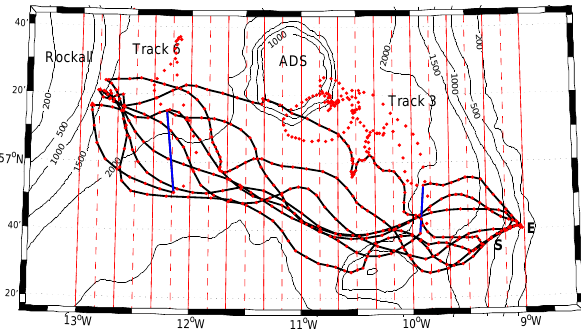
Figure 5. Glider track in the Rockall Trough from 18 October 2009 (S) to 5 March 2010 (E). Red dots are the dive positions. The black track connects those points used for averaging, with the blue lines connecting the gaps in tracks 3 and 6 (see Table 1 and Figs. 6 and 7). Vertical red lines delimit the 20 (cid:48) (plain) and 10 (cid:48) (dashed) zonal averaging bins. Isobaths are in